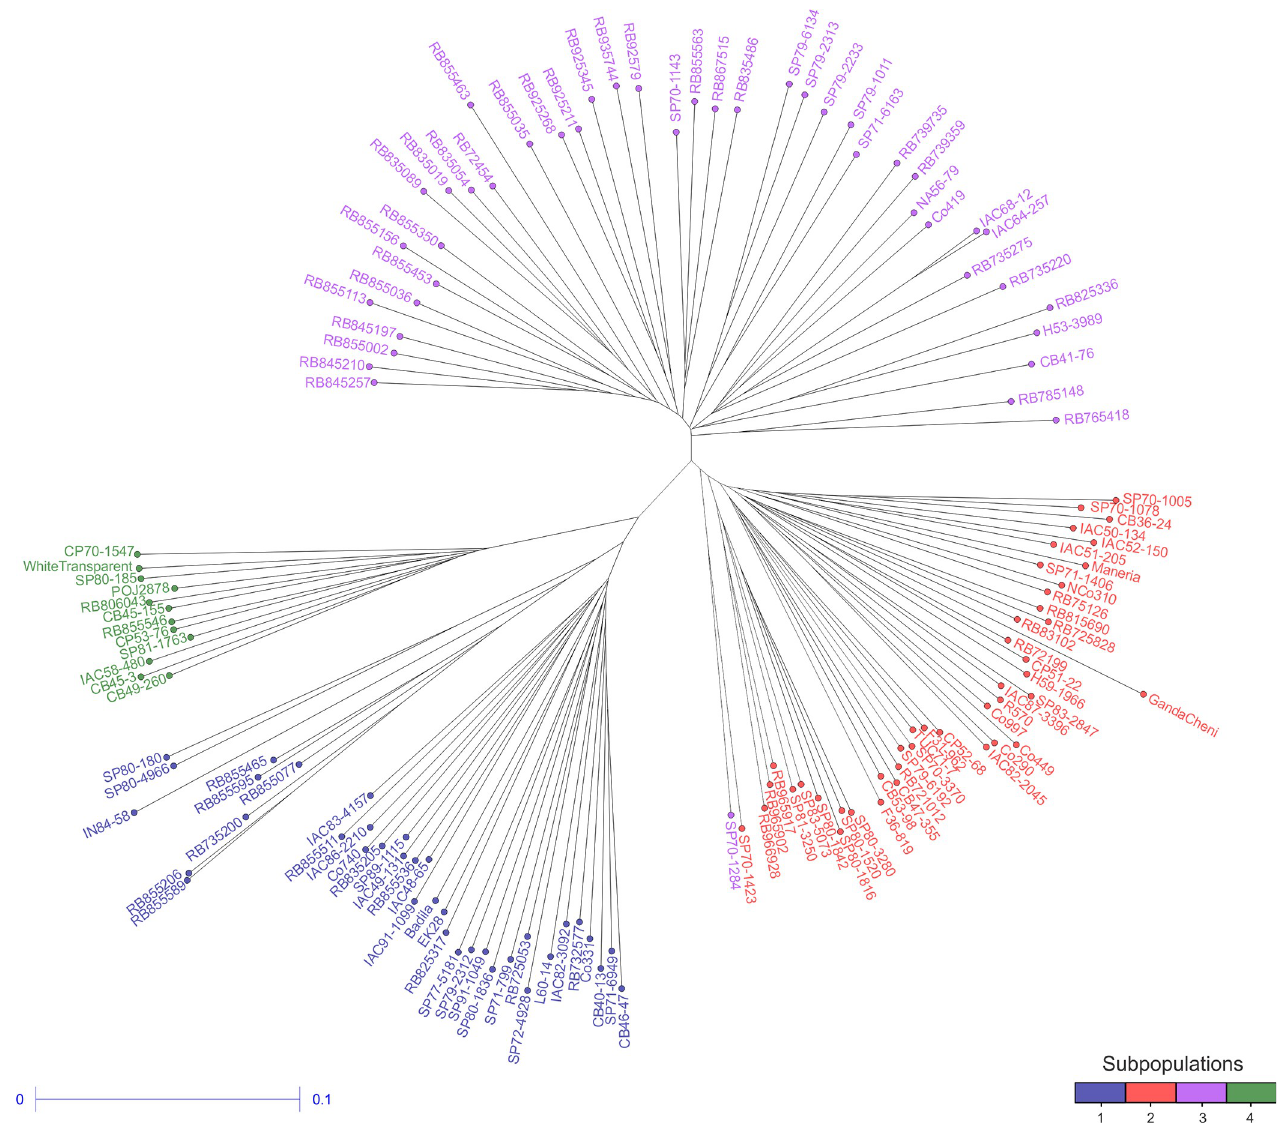
Fig 3. Neighbor-joining (NJ) tree for the BPSG using the SM method. Accessions indicated with the same color belong to the same subpopulation according to